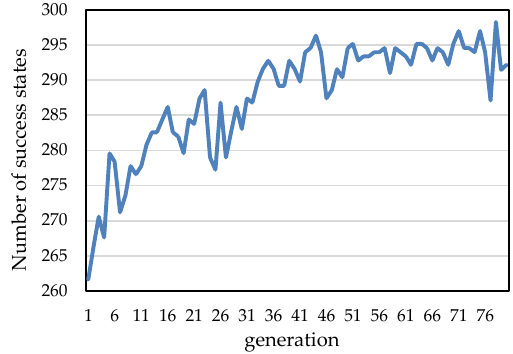
Figure 7. The trend graph that the number of success states change along with the generation.